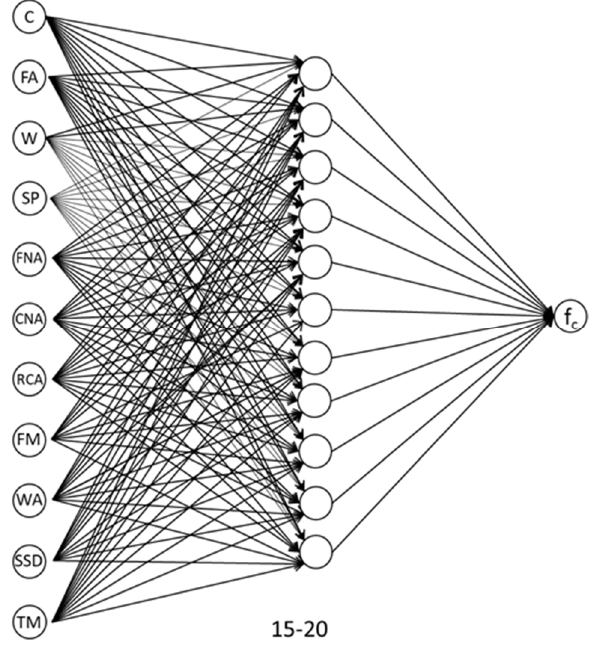
Figure 1. ANN architecture followed in the tests.